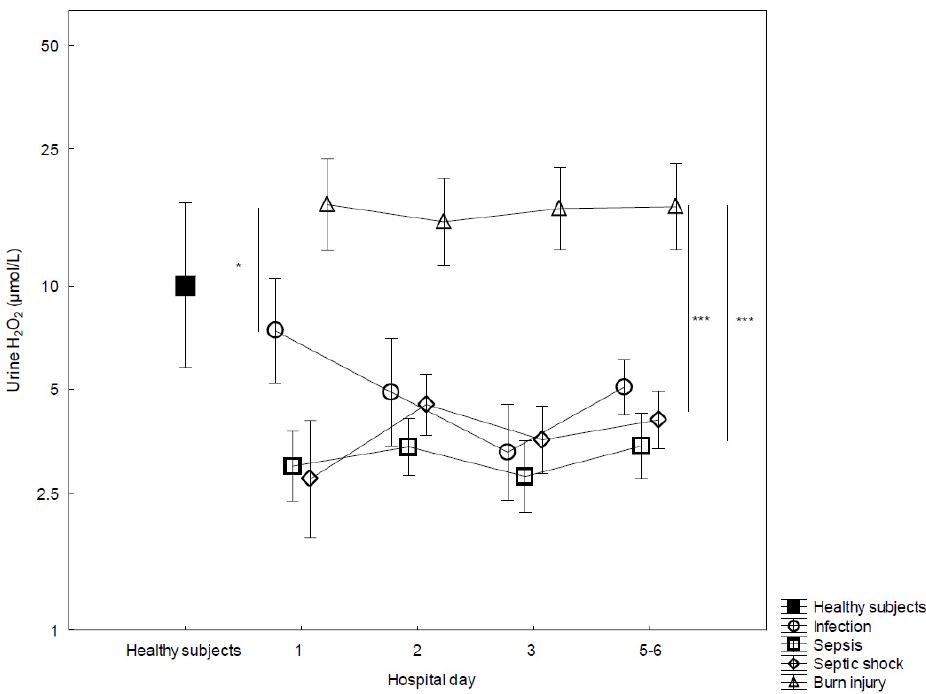
Figure 1. Concentrations of urine H 2 O 2 from admission (day 1) to day 5–6 in the ICU, stratified by sepsis ( n = 37), septic shock ( n = 23), infection ( n = 4) and major burn injury ( n = 18). H 2 O 2 concentrations in urine from healthy subjects ( n = 23) at one timepoint. ANOVA III for repeated measures was used to assess differences over time. Mean ± standard error of the mean (SEM). * p < 0.05, *** p < 0.001.